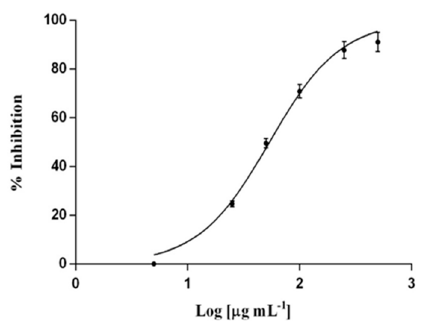
Figure 14. Inhibition of nitroxide production.